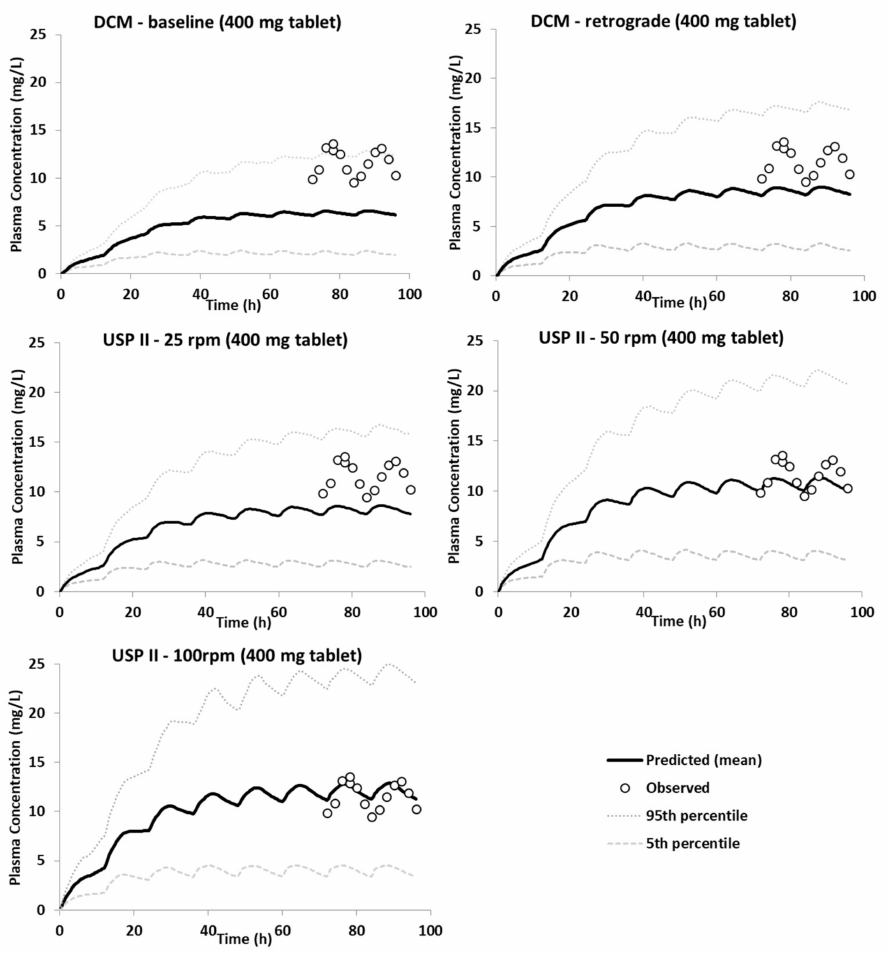
Figure 6. Predictions of the plasma concentration of theophylline after administration of a Uniphyllin Continus ® tablet (400 mg) b.i.d for 4 days using dissolution profiles obtained using agitation speeds of 25, 50 and 100 rpm in the USP II and four motility patterns in the DCM, as detailed in O’Farrell et al. [36].